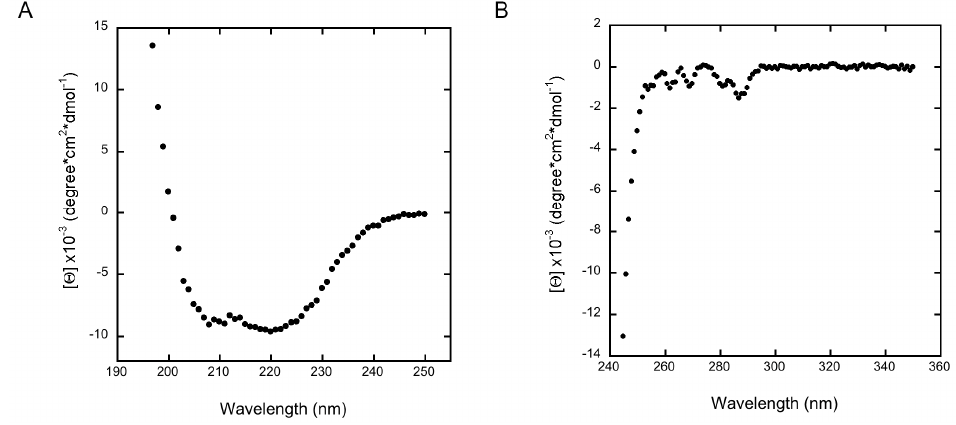
Figure 1. Circular dichroism spectra of Bcp1 in the far- ( A ) and near-UV ( B ).